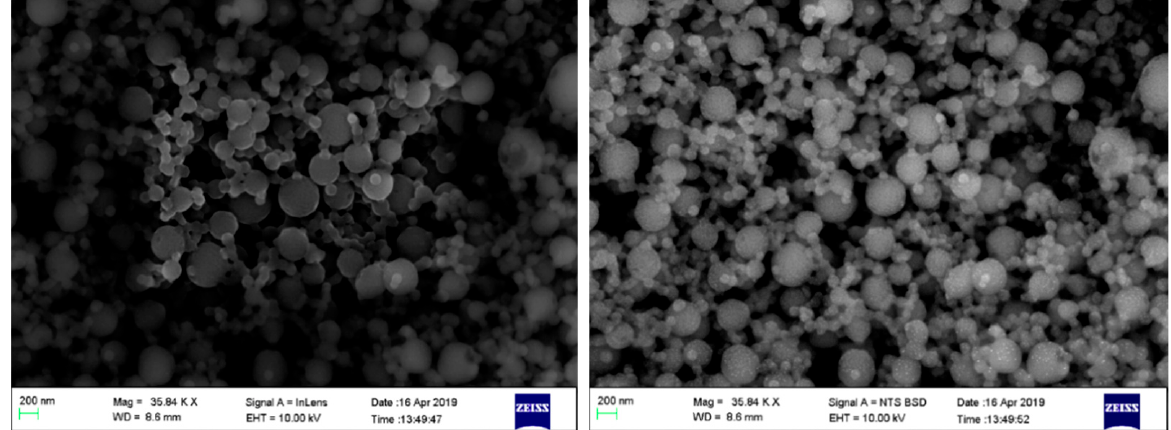
Figure 2. SEM micrographs of freeze-dried IgG loaded AZP nanospheres.